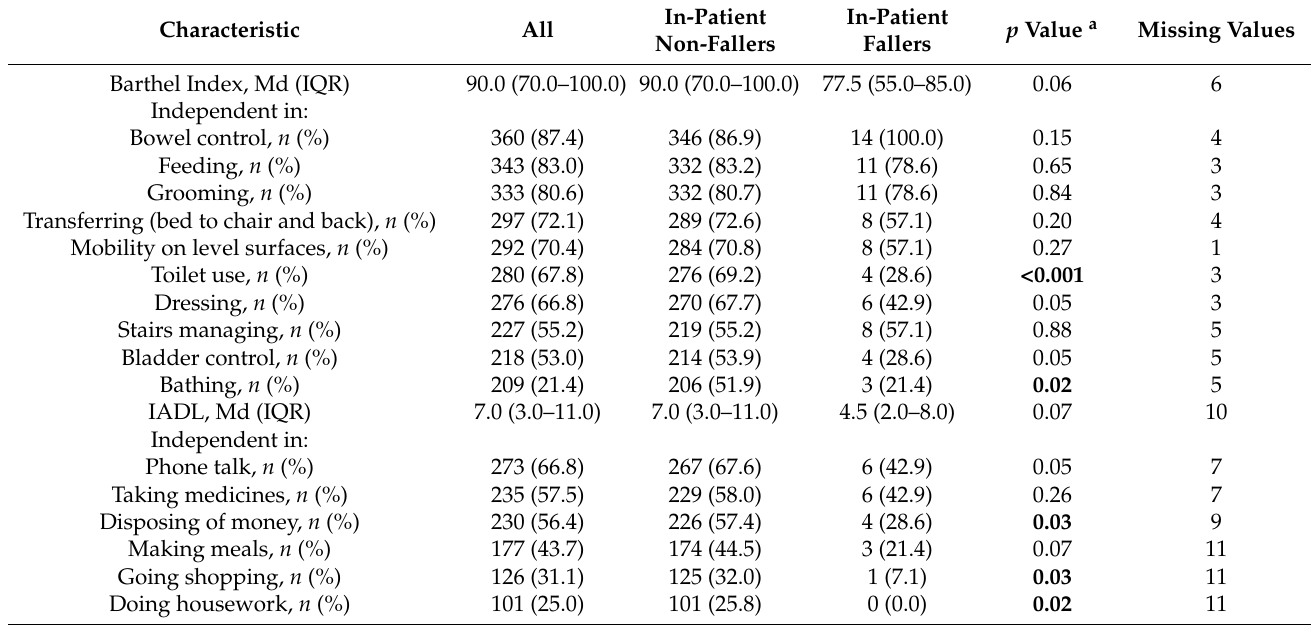
Table 4. Characteristics of study participants—ADL and IADL correlates of falls.